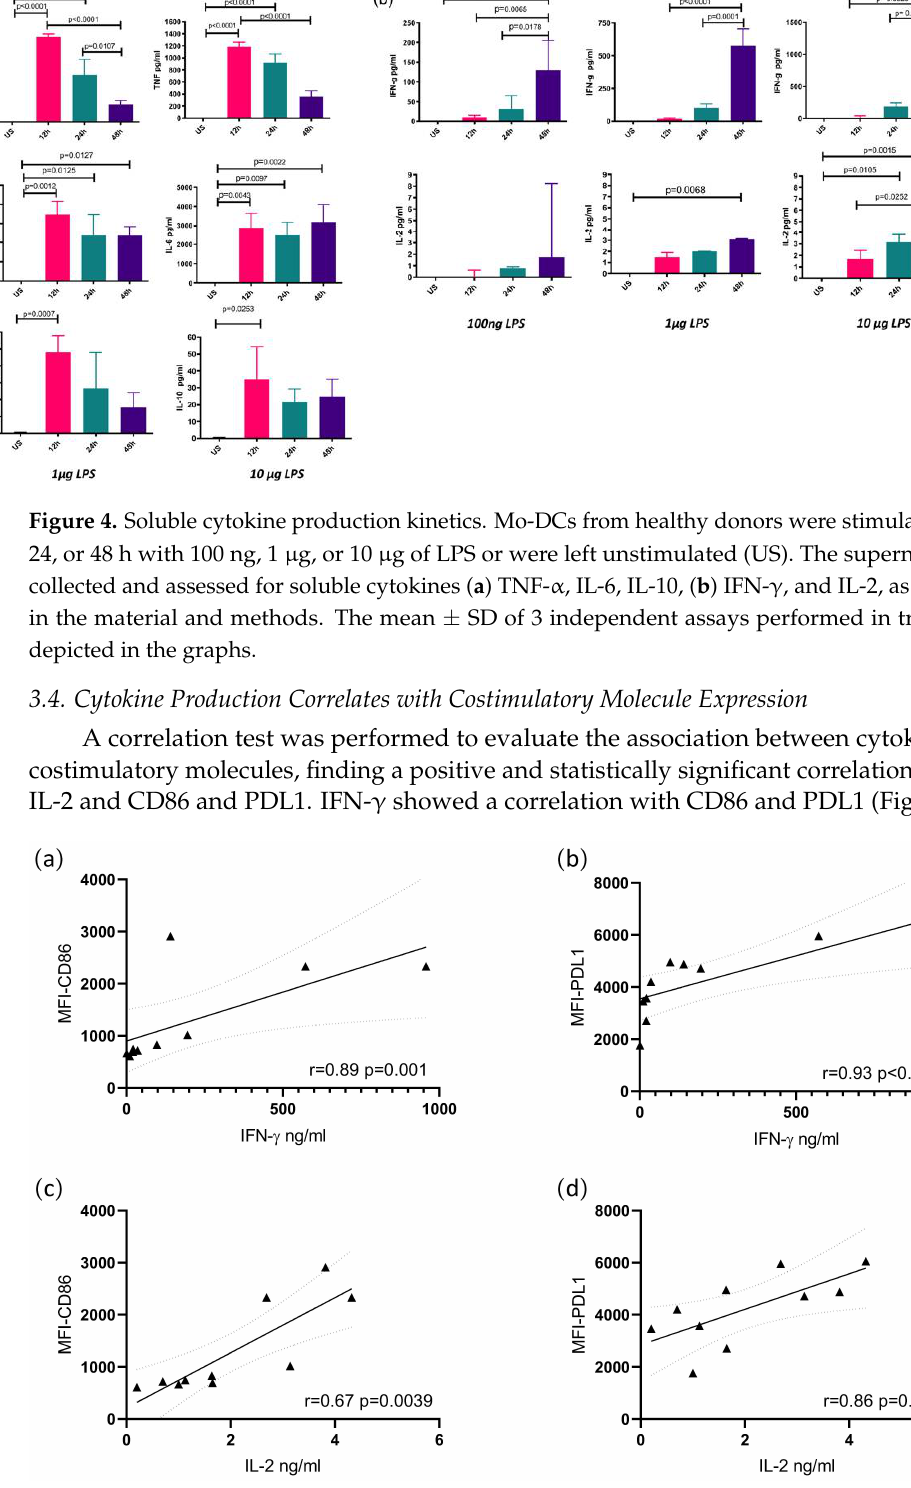
Figure 5. Correlation between cytokine production and costimulatory molecule expression. A Pearson correlation was performed by plotting the concentration of each cytokine vs. the MFI of each costimulatory molecule in the same experimental conditions. ( a ) IFN γ vs. CD86, ( b ) IFN γ vs. PDL1, ( c ) IL-2 vs. CD86, ( d ) IL-2 vs. PDL1. (cid:78) Represents individual correlation